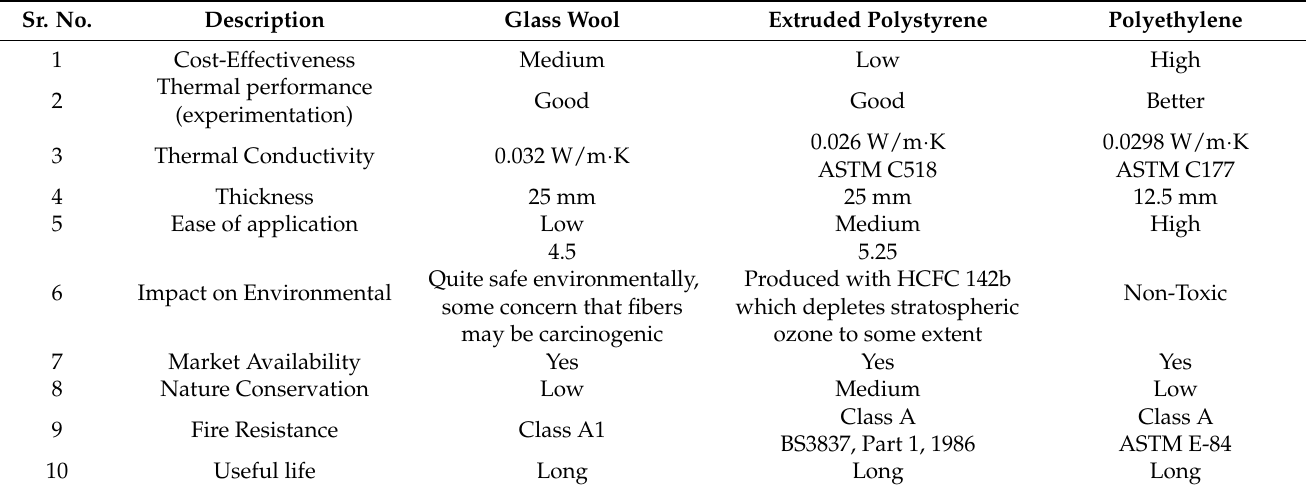
Table 5. Comparative analysis of different parameters for three different types of insulation materials, extracted from